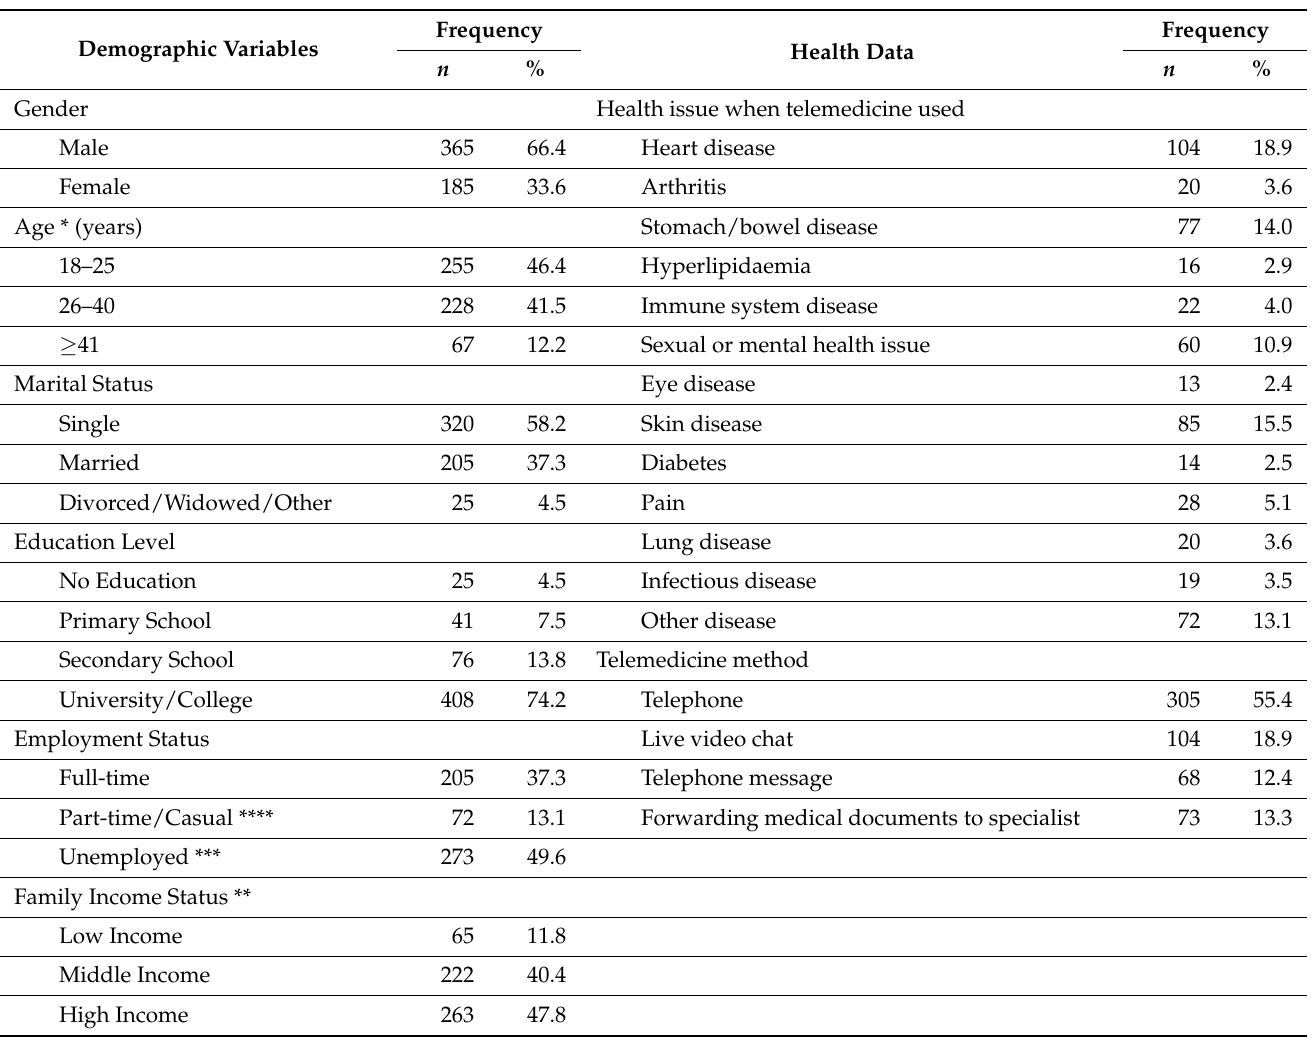
Table 1. Participants’ demographic variables, health data, and telemedicine modes ( n =